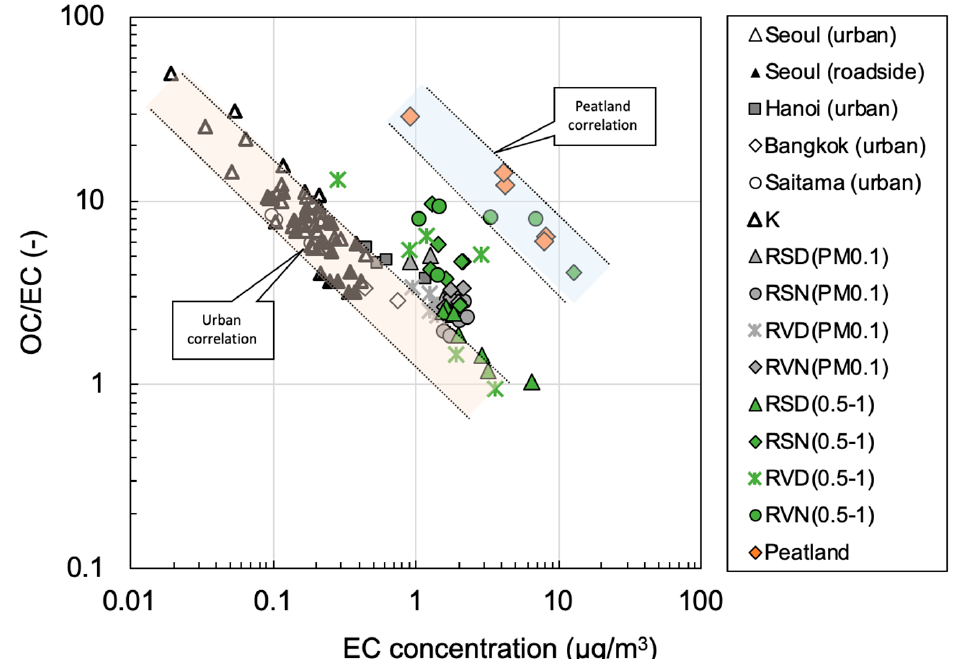
Figure 6. OC/EC vs. EC in RS and RV and urban sites in several Asian countries.